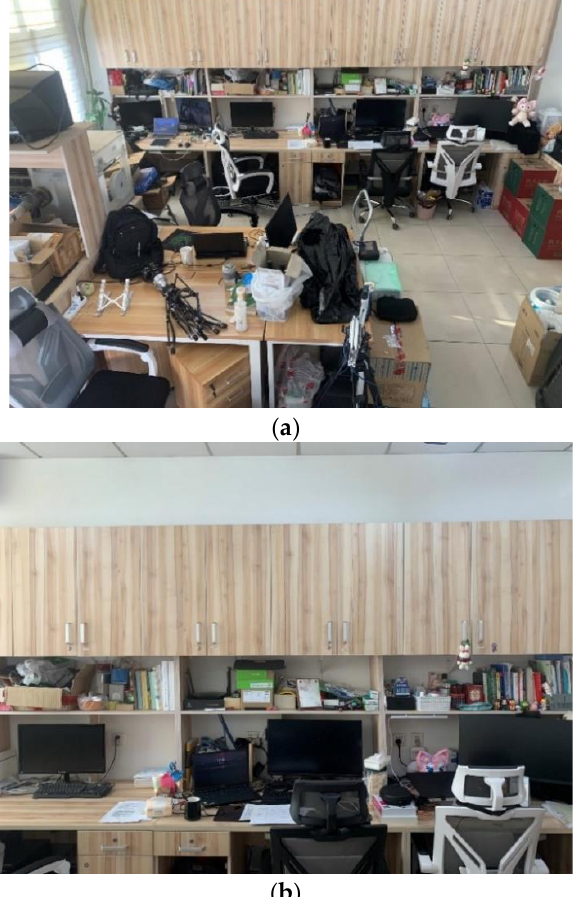
Figure 9. Images of experimental environment. ( a ) Overall appearance. ( b ) Tables and lockers.